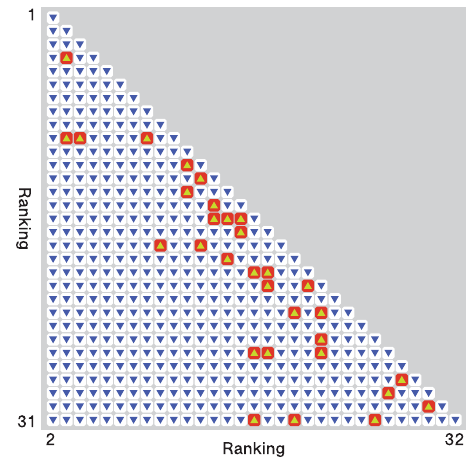
Fig. 1 An illustration of dominance relations within a group of Leghorn hens ( Gallus gallus domesticus ) observed in 1946 3 . (Data available at http://konect.cc/networks/moreno_hens/) The rows and columns correspond to the identi fi cation numbers of individual hens. Arrows show the dominance relations — an arrow at row i and column j points down if i dominates j , and up if j dominates i . The ranking is obtained by a simple greedy relabeling (i.e., not necessarily the one minimizing the number of discordant pairs with respect to the ranking — a so-called “ minimum violation ranking ” ). As typical for real-world rankings of many kinds, we can see that pecking orders of hens are not complete, linear rankings 1